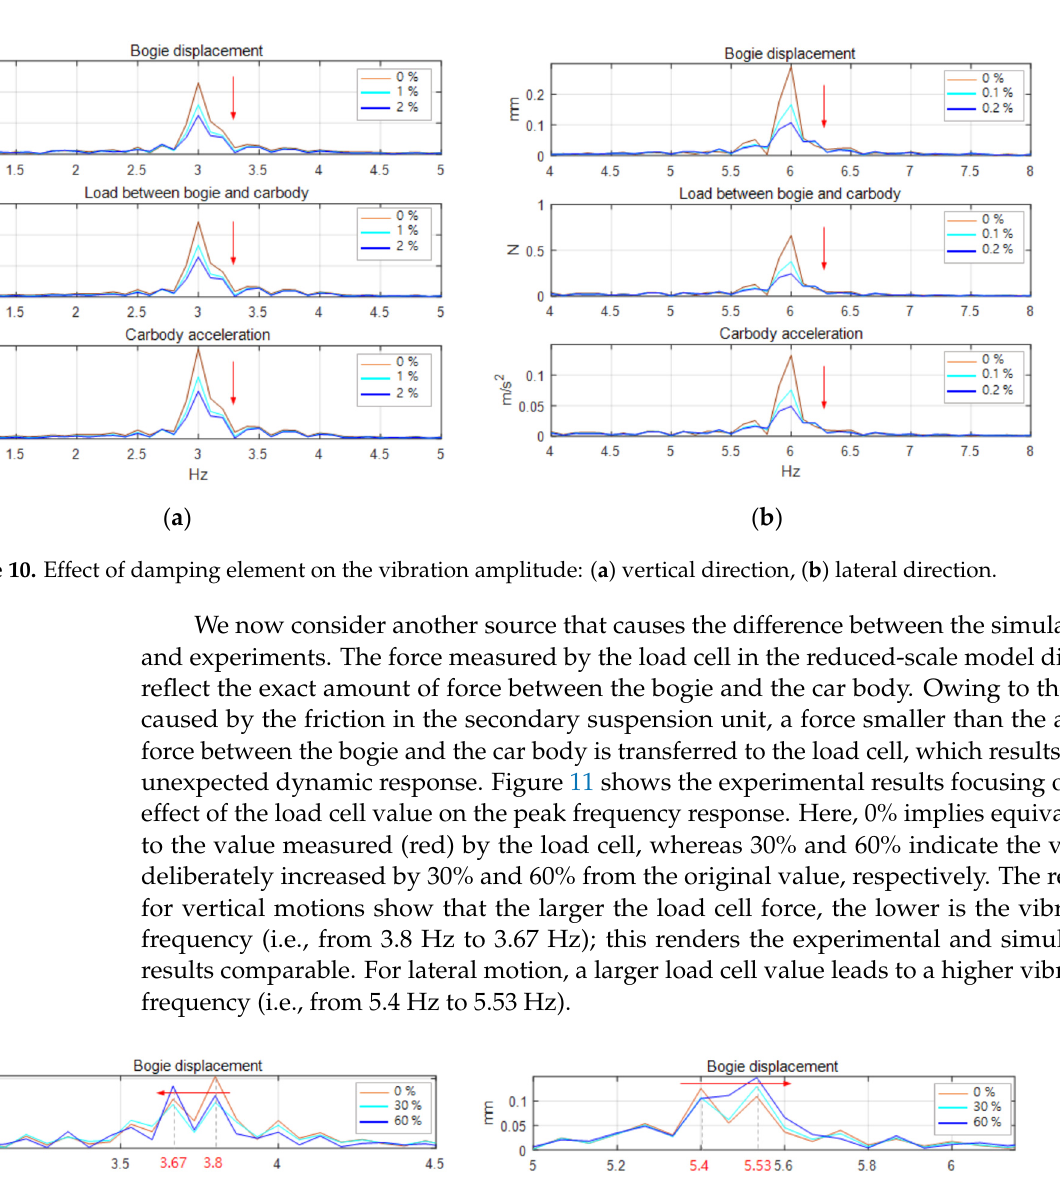
Figure 11. Effect of load cell value on vibration frequency: ( a ) vertical direction, ( b ) lateral direction.